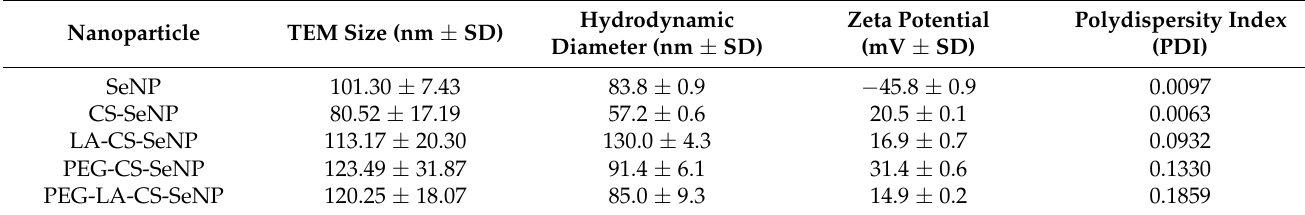
Figure 4. TEM images of ( A ) SeNPs, ( B ) CS-SeNPs, ( C ) LA-CS-SeNPs, ( D ) PEG-SeNPs, and ( E ) PEG-LA-CS-SeNPs. Scale = 500 nm. Table 1. Size distribution, zeta potential and polydispersity indices of all nanoparticles.